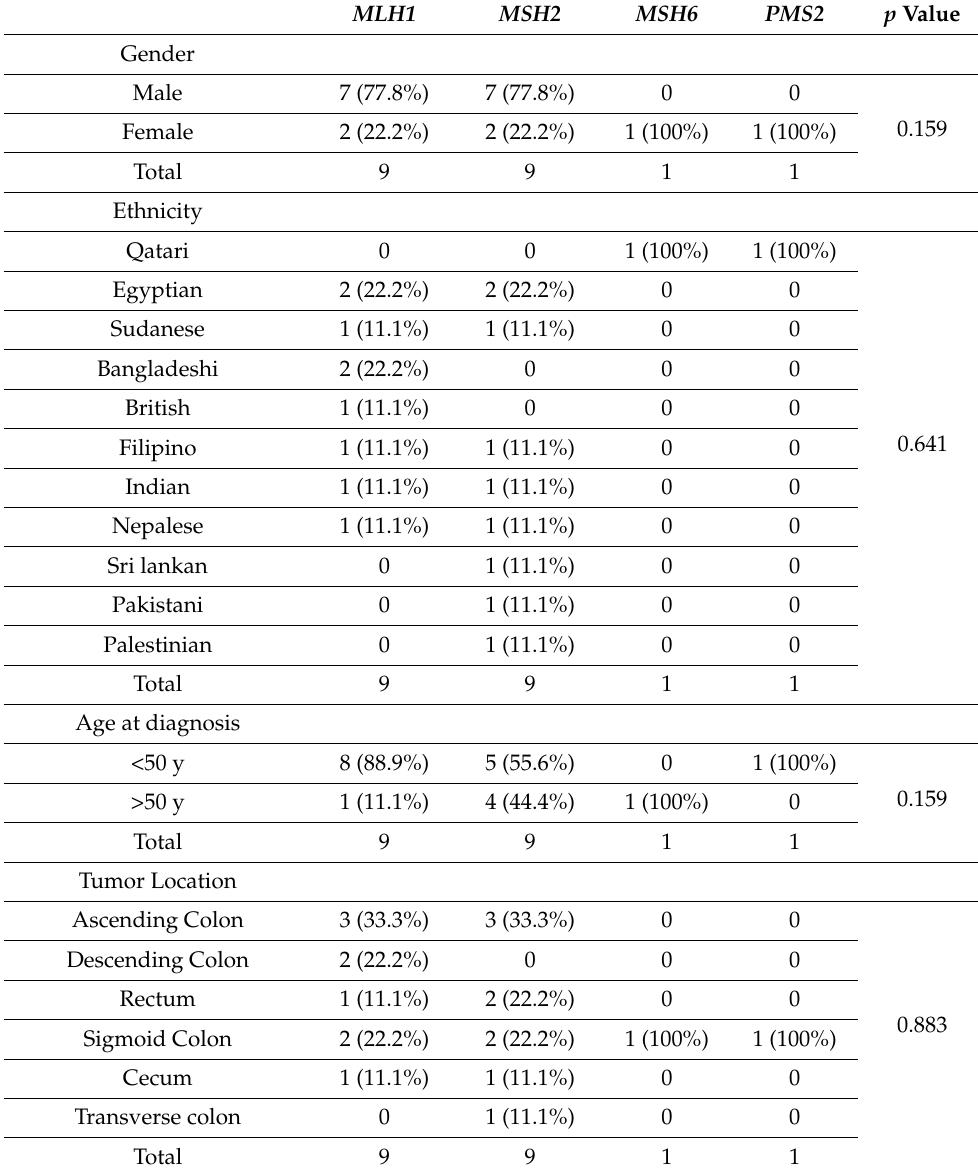
Table 5. Genotype- phenotype correlation with the mutated gene, LV: Lympho-vascular invasion, CRC: colorectal